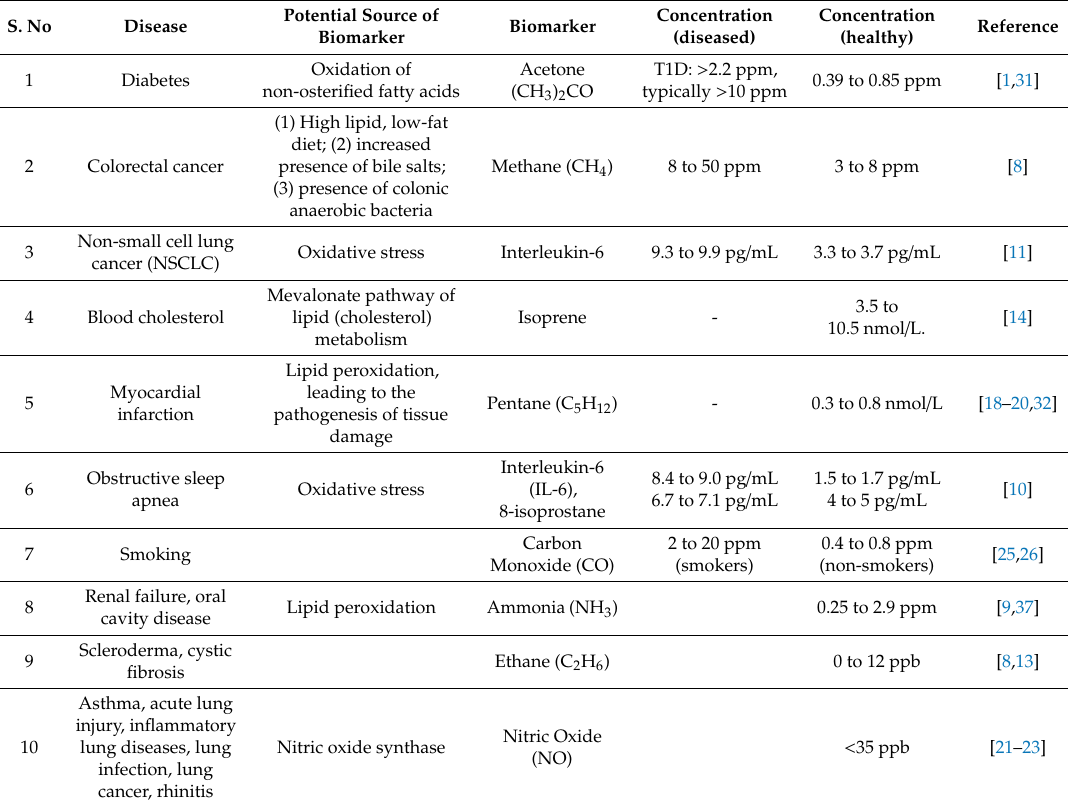
Table 1. List of biomarkers and their relation to potential disease